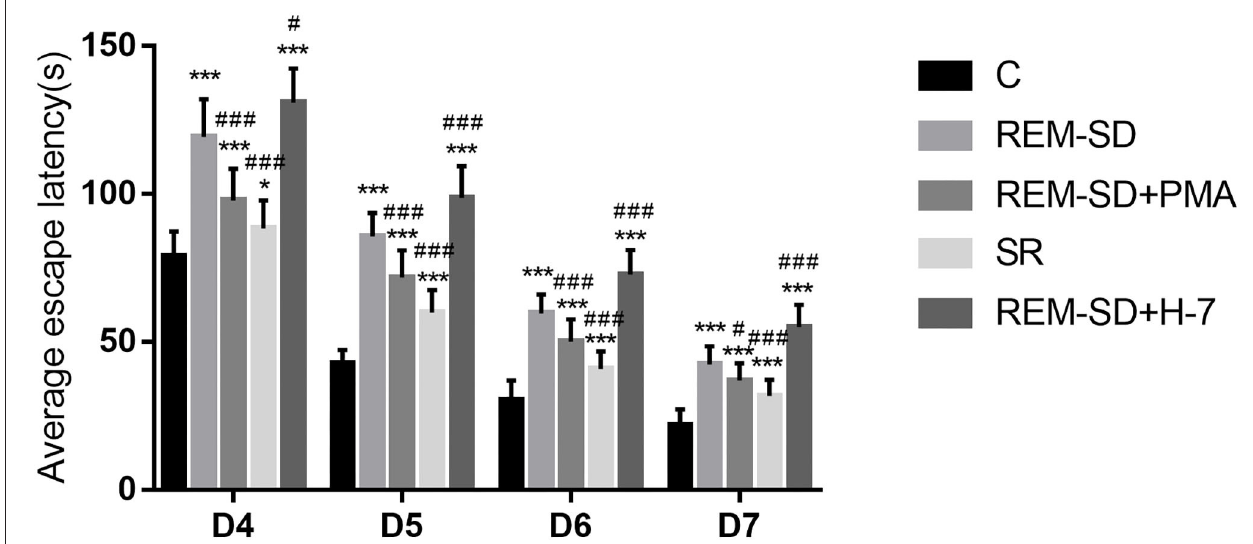
FIGURE 2 | Average escape latency (seconds) for all groups. Compared with the control group (C), the average escape latencies for all other groups were significantly prolonged on each day of training. Compared with the REM-SD group, the average escape latency was significantly shorter in the SR and REM-SD + PMA groups, and was significantly longer in the REM-SD + H-7 group * P < 0.05, # P < 0.05 vs. control group, *** / ### means P <